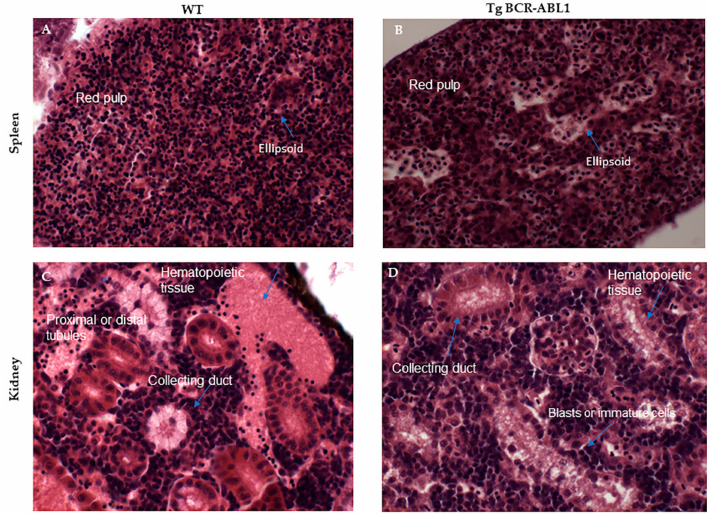
Figure 8. Hematoxylin-eosin staining on paraffin embedded longitudinal section (8 um) in wild type (WT) and tg BCR-ABL1 fish. Spleen ( A , B ) and kidney ( C , D ) are reported. Different histological and morphological structures are indicated blue arrows. (Magnification 40 × ) Bar 30